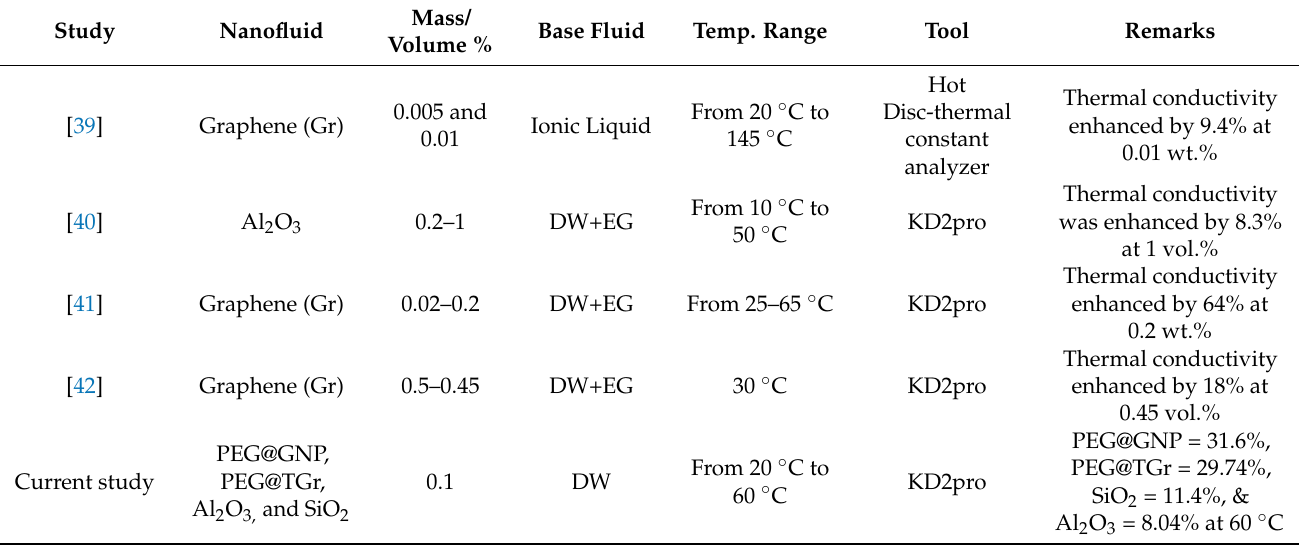
Table 2. Summary of thermal conductivity in previous experimental studies.